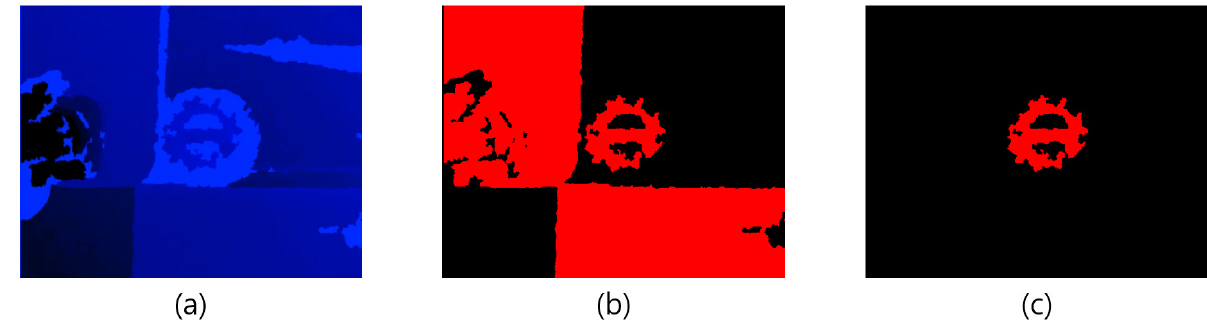
Figure 7. Example of depth image processing: ( a ) depth image is obtained, ( b ) it is converted into a binary image, and ( c ) border objects are removed.